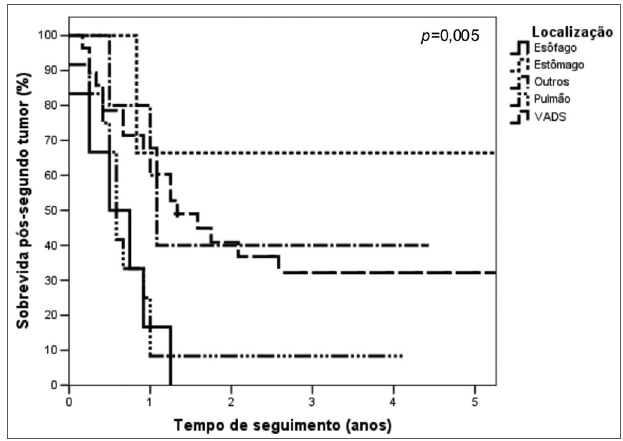
Figura 4. Curvas de sobrevida pós-segundo tumor primário de acordo com a localização do segundo